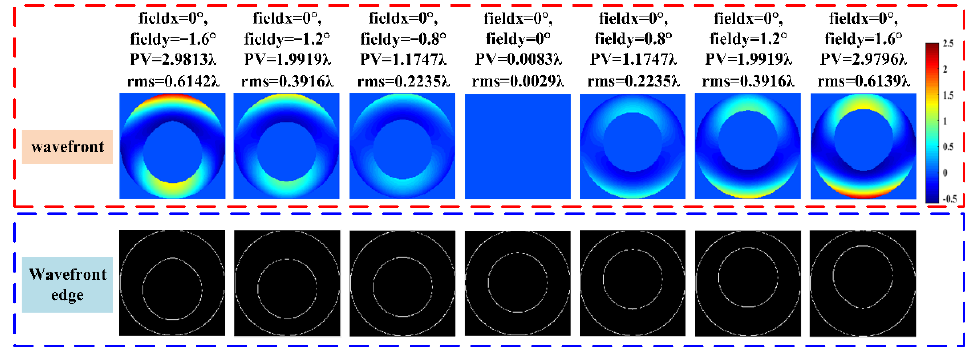
Figure 1. Wavefront corresponding to different fields of view. Table 1. Results of the circle fitting corresponding to wavefront in different fields of view.